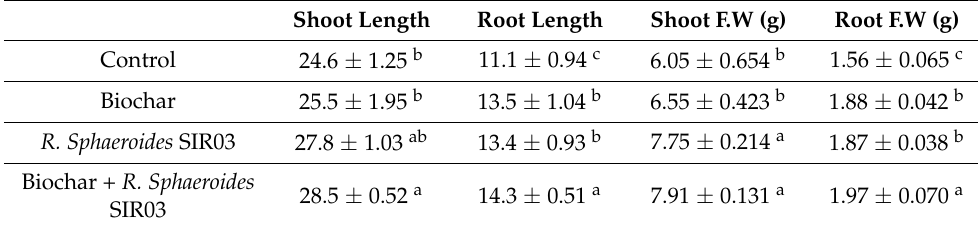
Table 3. Effects of isolate SIR03 on growth and biomass of sesame